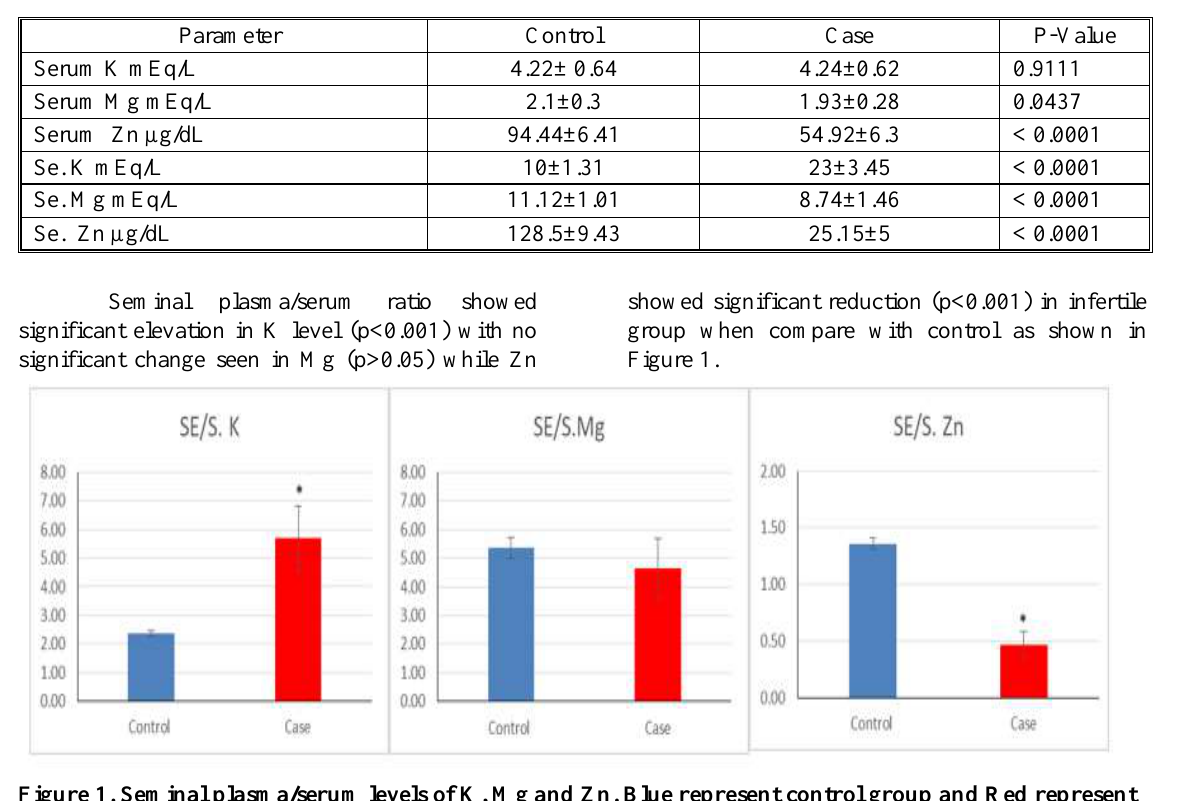
Table 3. Serum and seminal plasma potassium, magnesium and zinc levels in young infertile male in compare to healthy controls.